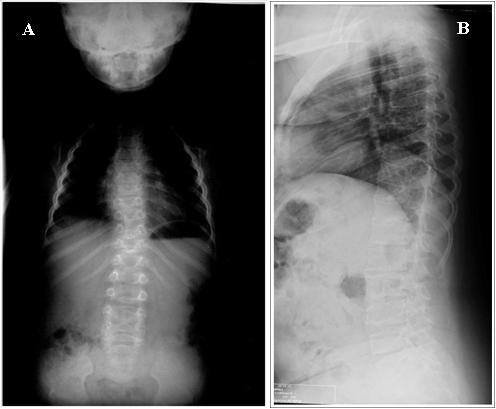
Radiographs of patient 1. A. 6 years. B. 28 years. Note generalized platyspondyly, thoracolumbar scoliosis.